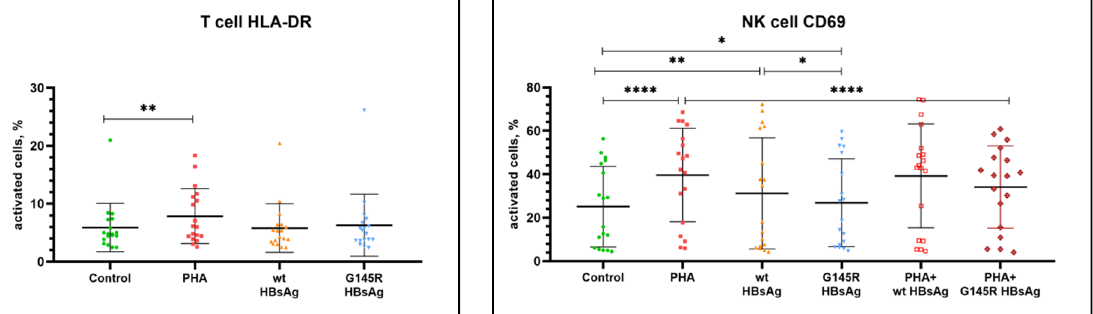
Figure 2. Assessment of surface markers on PBMC stimulated with wild-type rHBsAg, the rHBsAg G145R mutant, or PHA, or their combinations. Significant p values are reported as asterisks, where * p ≤0.05, ** p ≤ 0.01, and **** p ≤ 0.0001.